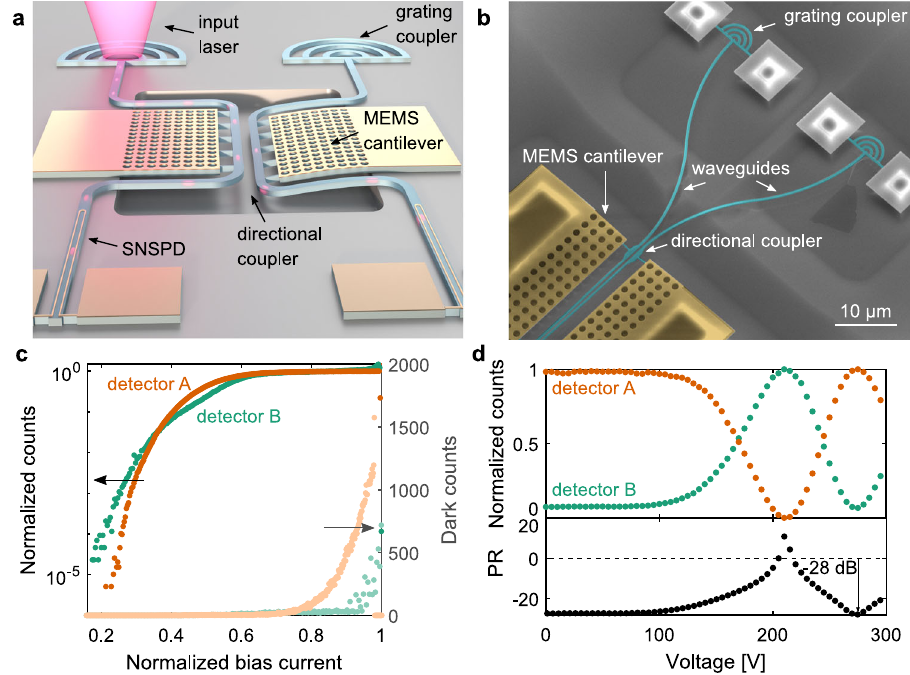
Fig. 1 Device description and characterization. a Artist view of the demonstrated device, composed of grating couplers for light input and a MEMS recon fi gurable beam splitter connected to two superconducting single-photon detectors. b False-colored SEM of the input section of our device, showing the waveguides and grating couplers, and the MEMS actuator and electrodes. c Photon count rate at a wavelength of 795 nm for the two on-chip detectors and the corresponding dark counts, normalized to their individual saturated detection. The reduced critical current in the dark count measurement of detector A is due to measurement-to-measurement fl uctuations in the critical current. d Measured photon detection counts versus MEMS actuation voltage, normalized to the individual maximum transmission and power ratio (PR) between detectors. Note that the detectors feature different detection ef fi ciencies (44.6 times higher in A, see Results